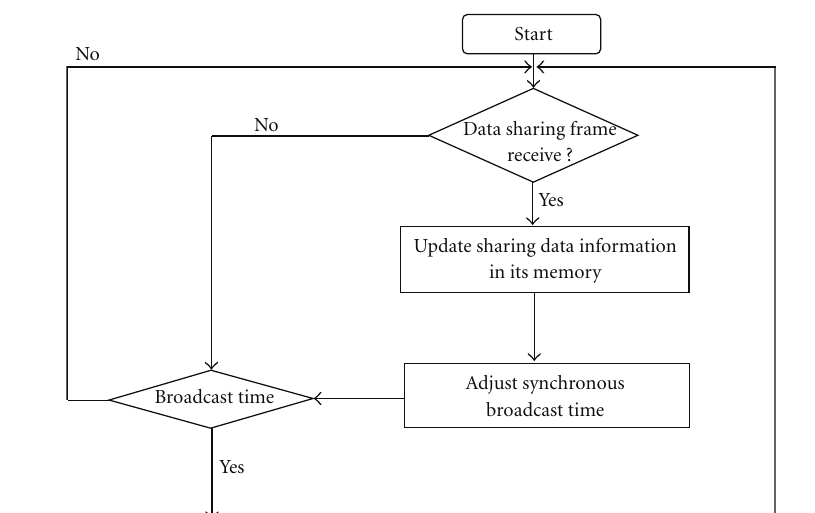
Figure 4: Structure of DSF.